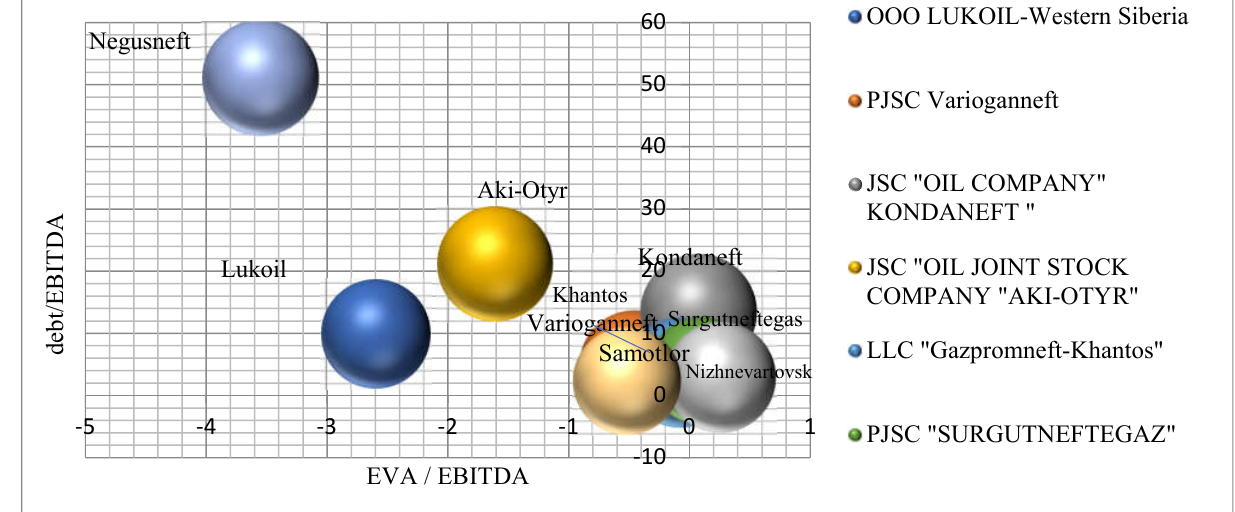
Figure 2. Investment attractiveness: positioning of an extractive industry enterprise. The most attractive companies are in the bottom right. Source: developed by Zadimidchenko A. The most undervalued companies according to the presented visualization will be in the bottom left, near the origin. A rational investor is left to choose a company from the bottom left, study it and invest in it, since these are the enterprises that are the least risky. Similar calculations were made for the manufacturing and energy sub-sectors of the fuel and energy complex of the Ural Federal District.